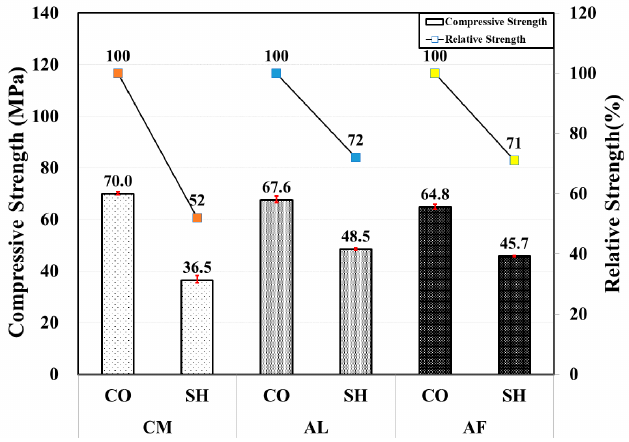
Figure 5. Compressive and relative strength by accelerators for 6-month-old specimens.